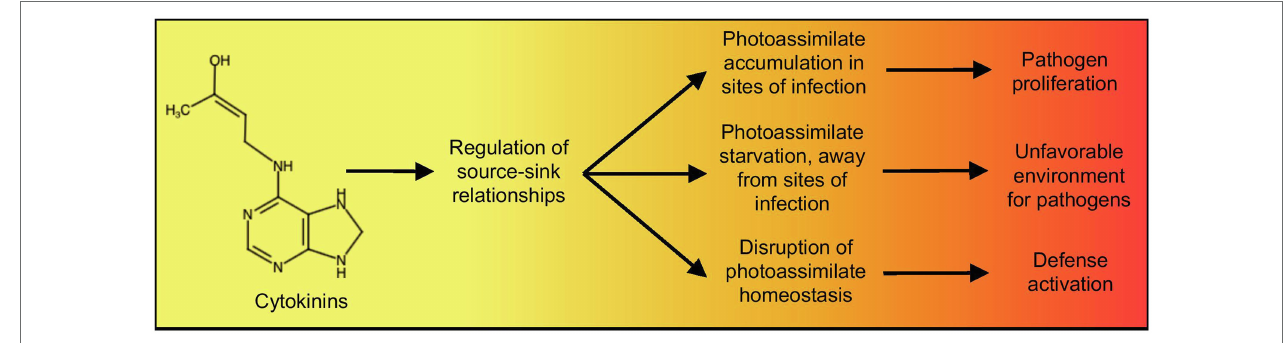
FIGURE 2 | Summary of the proposed effect of cytokinins, through their role in the regulation of source-sink relationships, on the outcome plant-pathogen interactions. Chemical structure created using